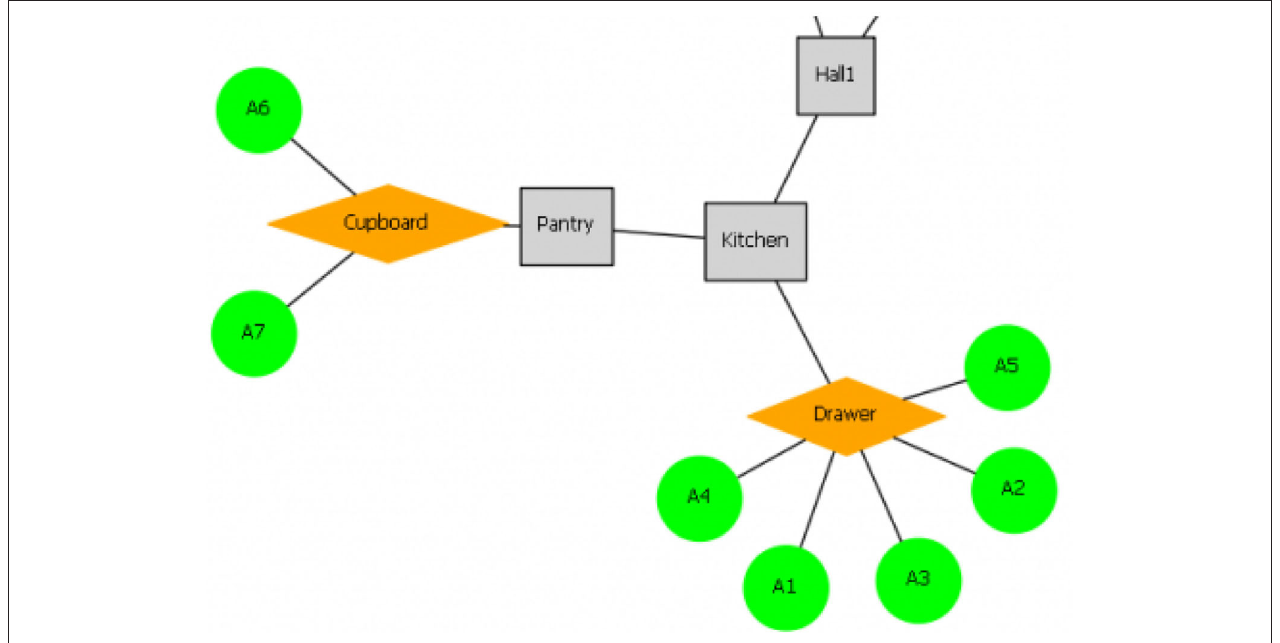
FIGURE 2 | An example of the spatial graph used in “the Chantry” . This represents the locations and objects that a player can access [fig:spatial]. Gray nodes represent overall locations (rooms) that a player can visit, orange nodes represent items a player can interact with to reveal objects, and green nodes represent objects that can be picked up and interacted with.